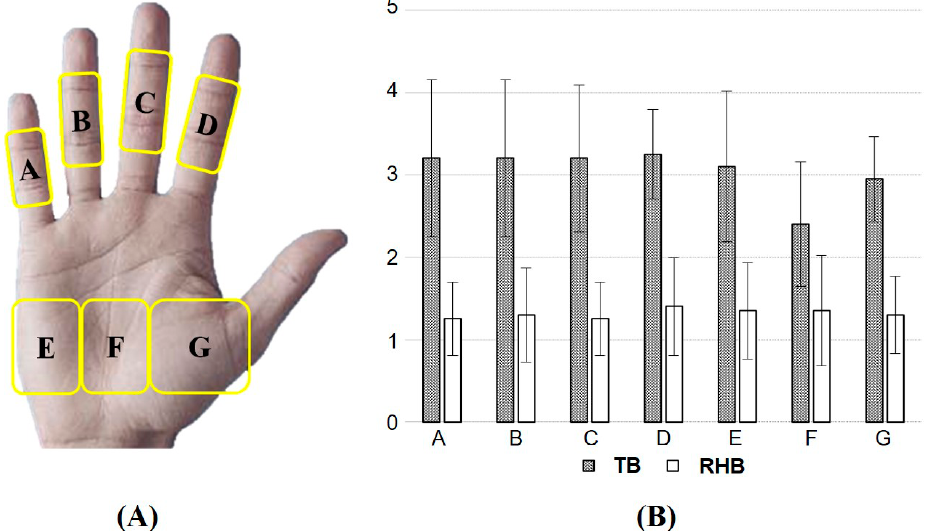
Figure 6. ( A ) Locations (A–G) on the hand, ( B ) Scores of locally perceived discomfort with a typi- cal harvesting basket (TB) and a harvesting basket with attached the rotational handles (RHB).